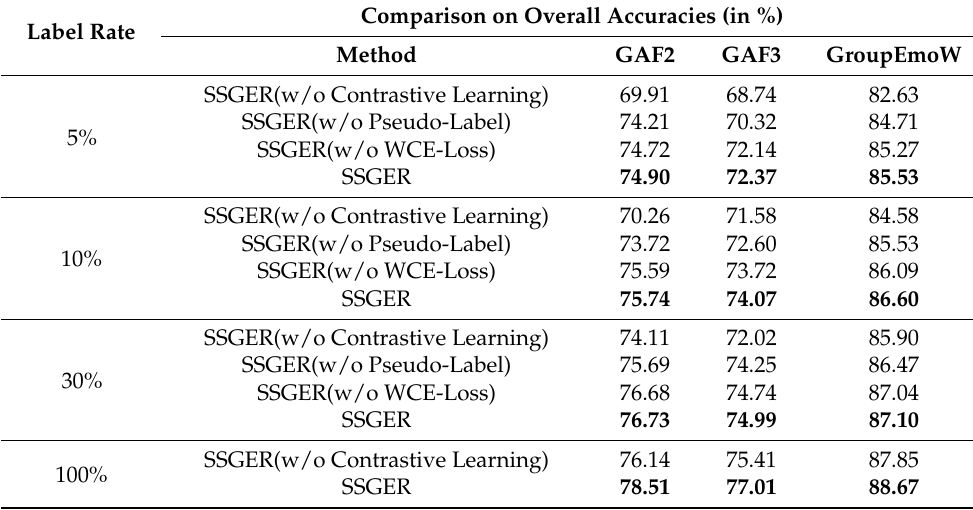
Table 5. Comparison on the performance of variant SSGER methods. The values in bold font denote the best accuracy. SSGER (w/o contrastive learning) denotes the framework without using contrastive learning, SSGER (w/o pseudo-label) denotes the framework without giving pseudo-labels, and SSGER (w/o WCE-Loss) denotes the framework without introducing WCE-Loss. Comparison on Overall Accuracies (in Label Rate